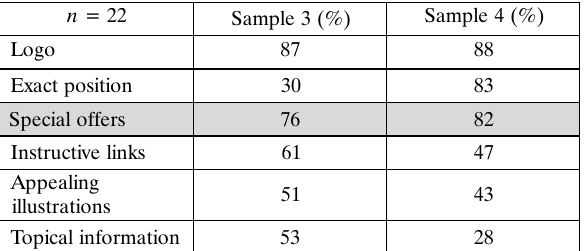
Table 3. Specific website features remembered